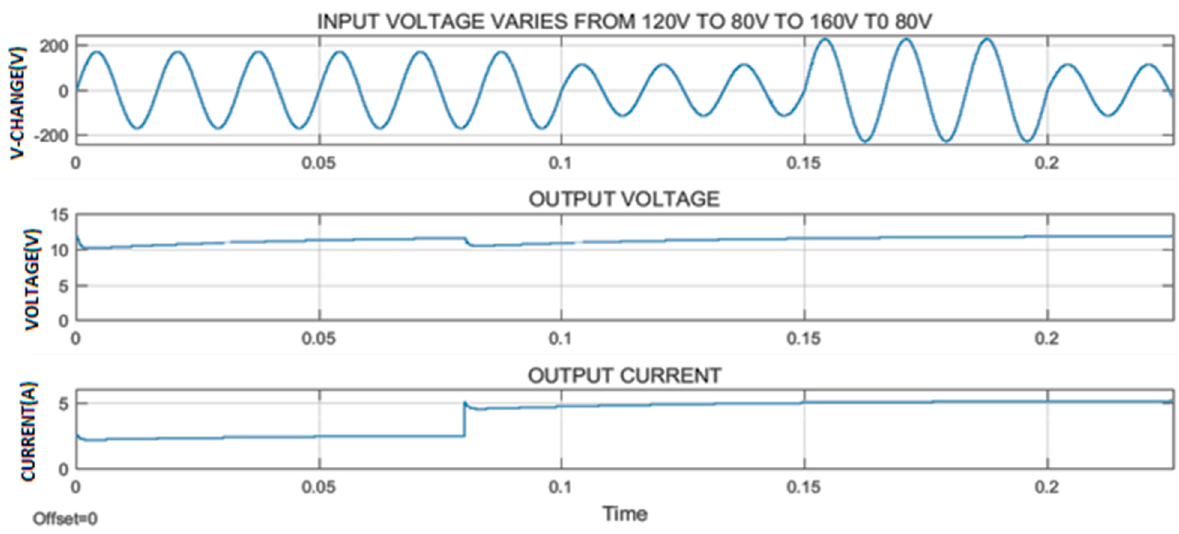
Figure 21. Fuzzy logic controller simulation results.